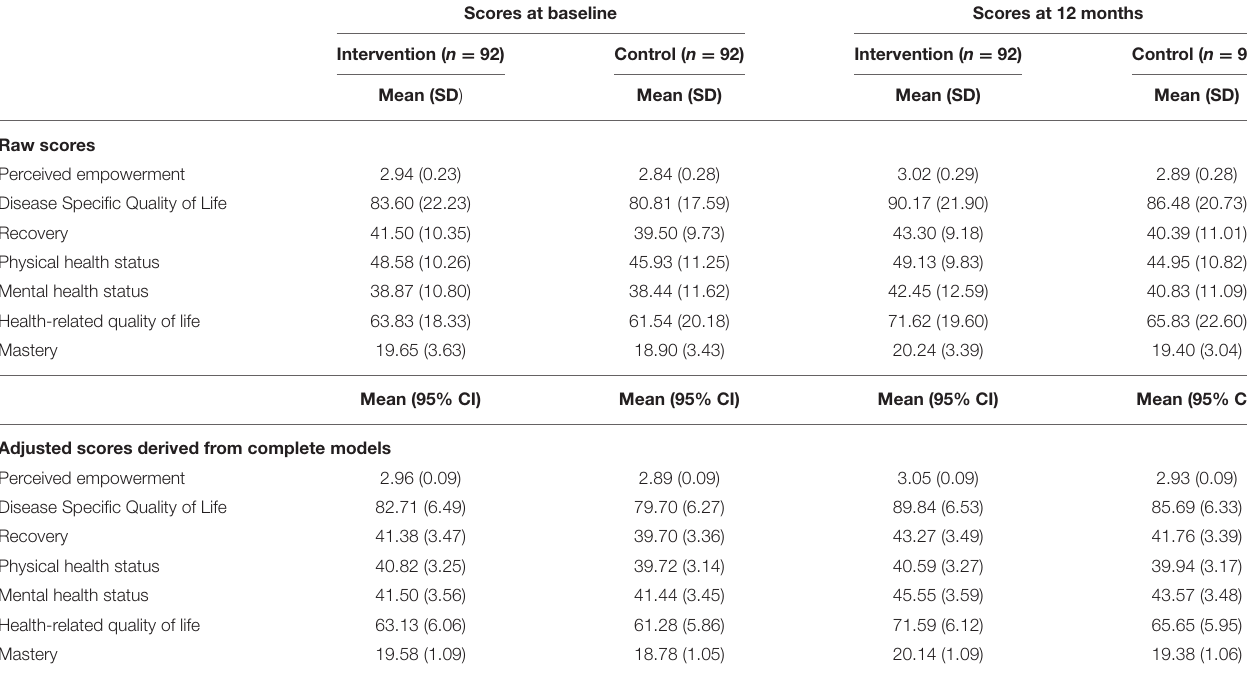
TABLE A1 | Mean scores and standard deviations (SDs) on outcome measures at baseline and at 12 months follow-up for intervention and control group participants ( a priori